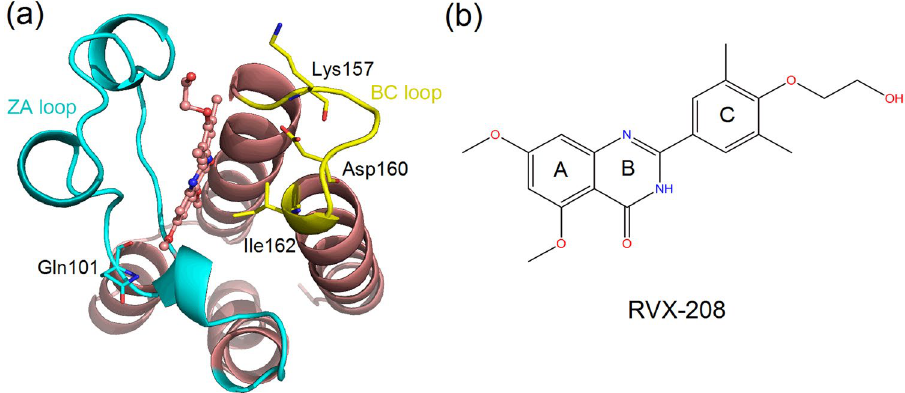
Figure 1. ( a ) The constructed complex structure of RVX-208 with BRD2-BBD1 and ( b ) The molecular structure of RVX-208. Blue and yellow cartoon regions represent ZA and BC loops, respectively. Residues in stick model are BRD2-BD1-specific in the pocket.